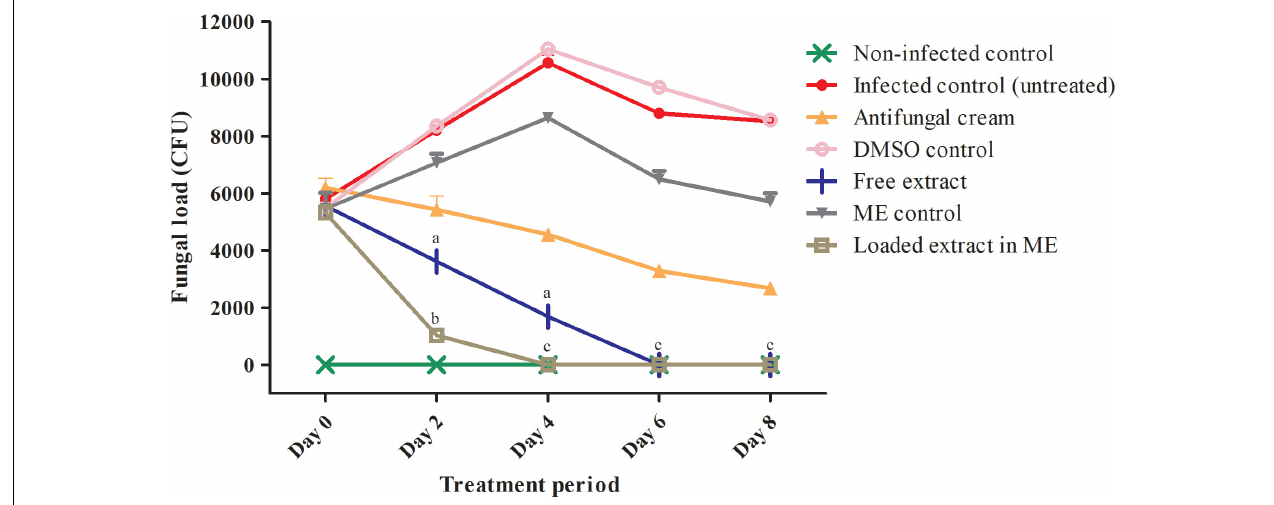
FIGURE 2 | Fungal loads detected in vaginal lavages from animals in different experimental and control groups on days 0, 2, 4, 6, and 8 of treatment. ME, microemulsion. Different letters in superscripts in columns indicate statistically significant differences ( P < 0.05) according to two-way ANOVA with post-test Tukey. a Comparison between the free extract and the DMSO control. b Comparison between the loaded extract and the microemulsion control. c Comparison between the loaded and the free extract. ∗ Undetectable fungal burden for the animals treated with the free extract (days 6 and 8) and the loaded extract (days 4, 6, and